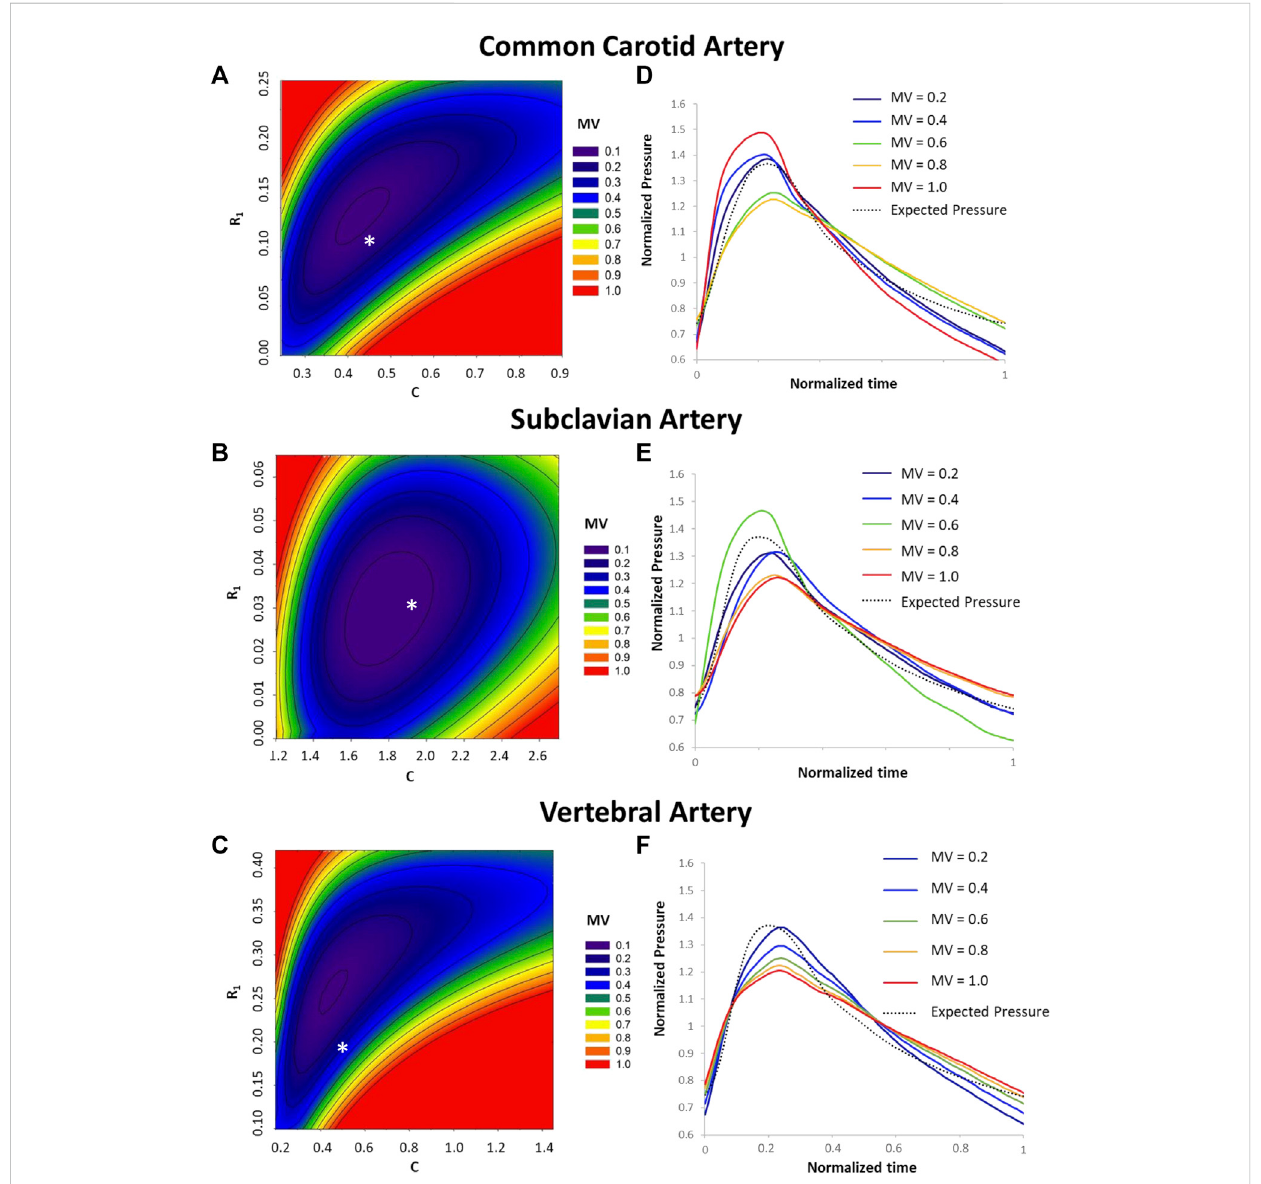
FIGURE 5 Sensitivity analysis ofpredicted pressureonvariations ofR 1 ,C,andR 2 .Contour plotofminimizedvalues(MV)underdifferentcombinationsoftheR 1 and C values are shown for common carotid artery (A) , subclavian artery (B) , and vertebral artery (C) . For reference, the medians of normalized R 1 and C values for each type of artery (Table 2) are shown by an * in A, B, and (C) . The minimized value is one of the outputs from the Optimization toolbox and quanti fi es the difference between the predicted and expected pressure values under a set of R 1 , C, and R 2 values. A smaller minimized value corresponds to a better overall match between predicted and expected pressures. Plots of the normalized pressure waveforms under some minimized values are shown for common carotid artery (D) , subclavian artery (E) and vertebral artery (F)